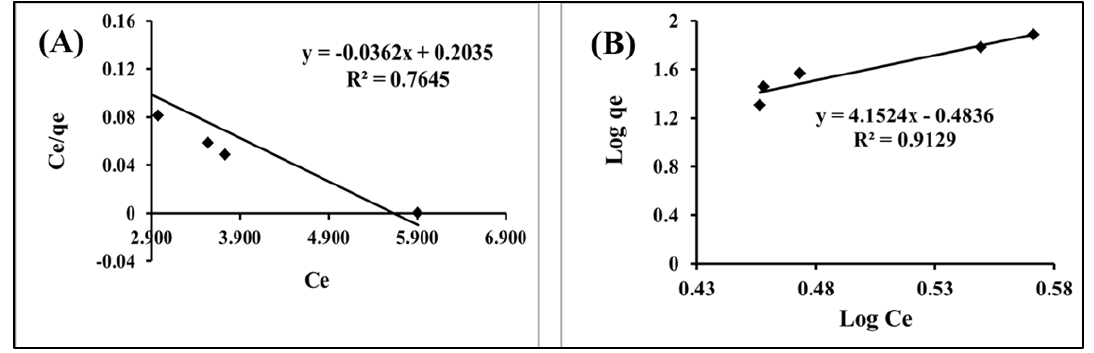
Figure 7. ( A ) Langmuir adsorption isotherms and ( B) Freundlich adsorption isotherm of Hg(II) ions onto IL-ACMRW (ionic liquid modified activated carbon from mixed recyclable waste).